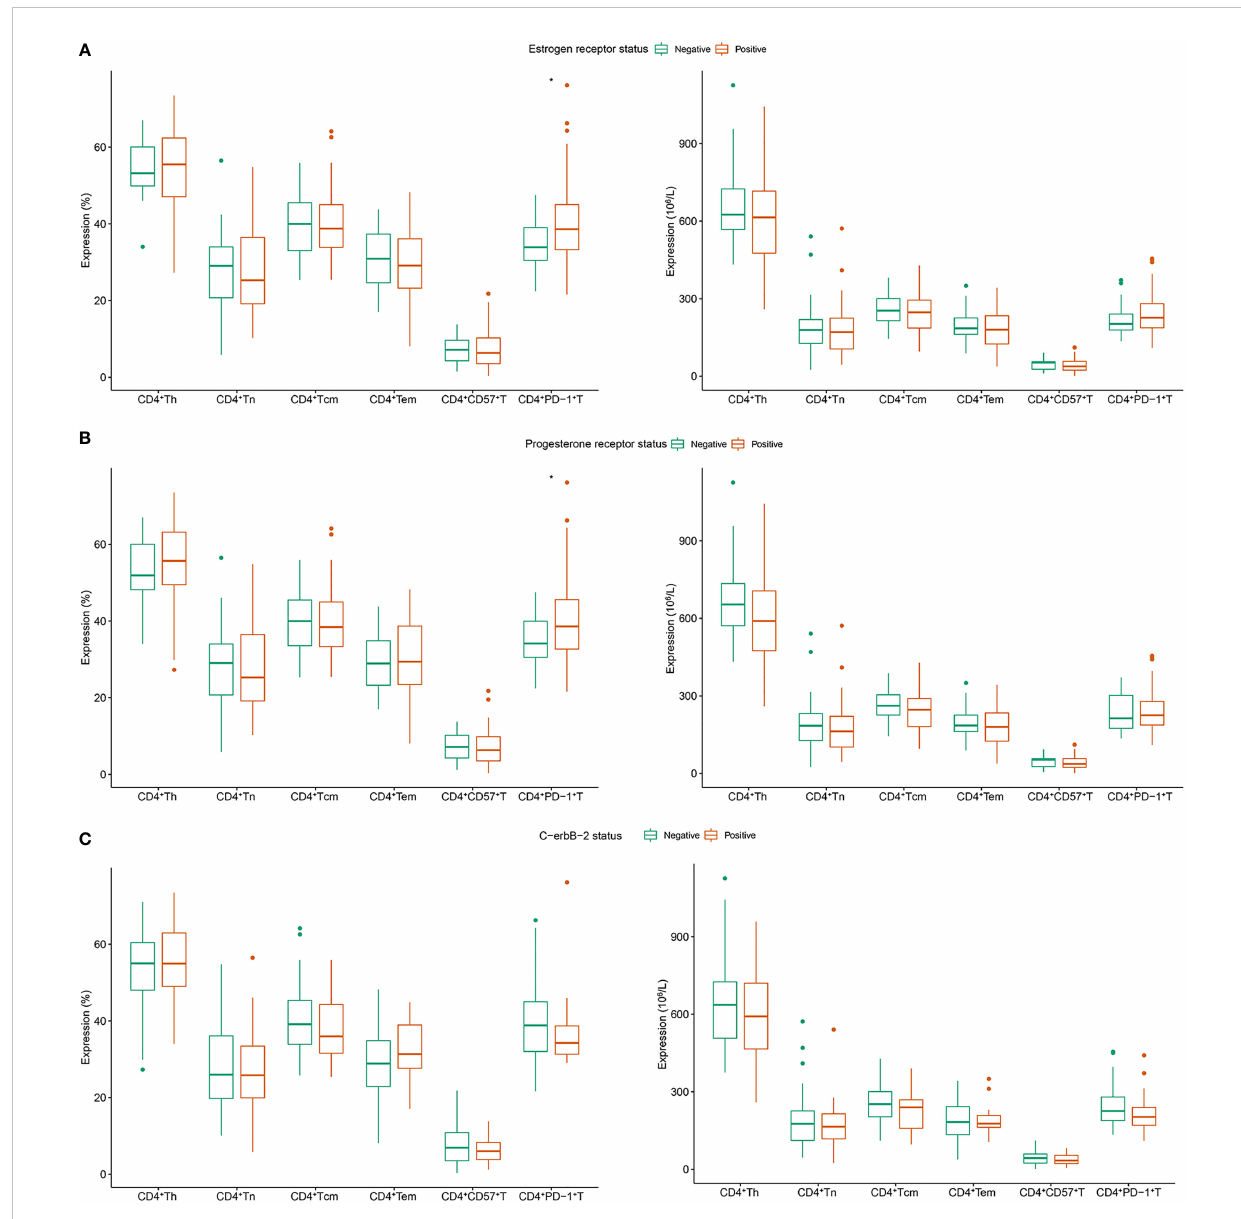
FIGURE 1 Correlation between CD4 + Th subsets and clinicopathology in patients with breast cancer. (A) Estrogen receptor; (B) progesterone receptor; (C) c- erbB-2. Tn, naive T cells; Tem, effector memory T cells; Tcm, central memory T cells; Th, helper T